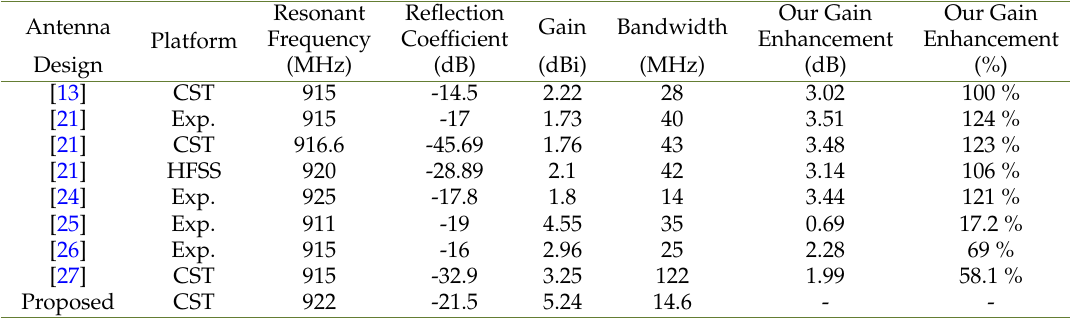
Table 2. Comparison between the proposed antenna and previous